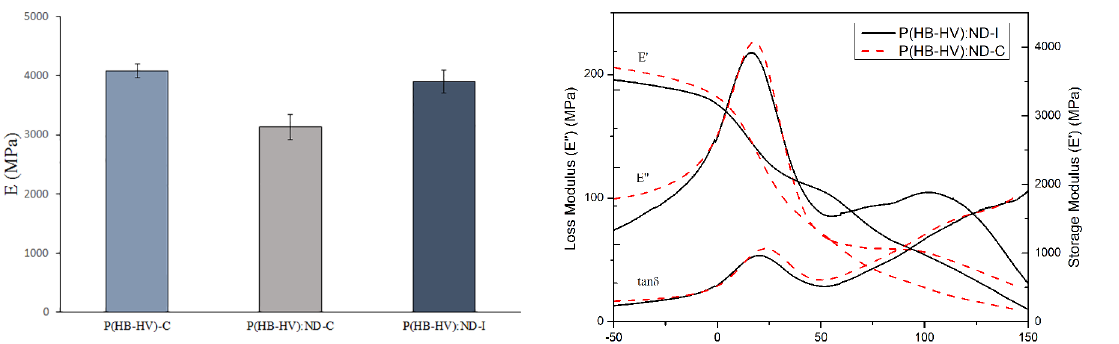
Figure 6. Elastic modulus obtained by nanoidentation of all formulations. Figure 7. Storage modulus, loss modulus and tanδ variation with temperature, curves obtained by DMA for P(HB-HV):ND-I and P(HB-HV):ND-C